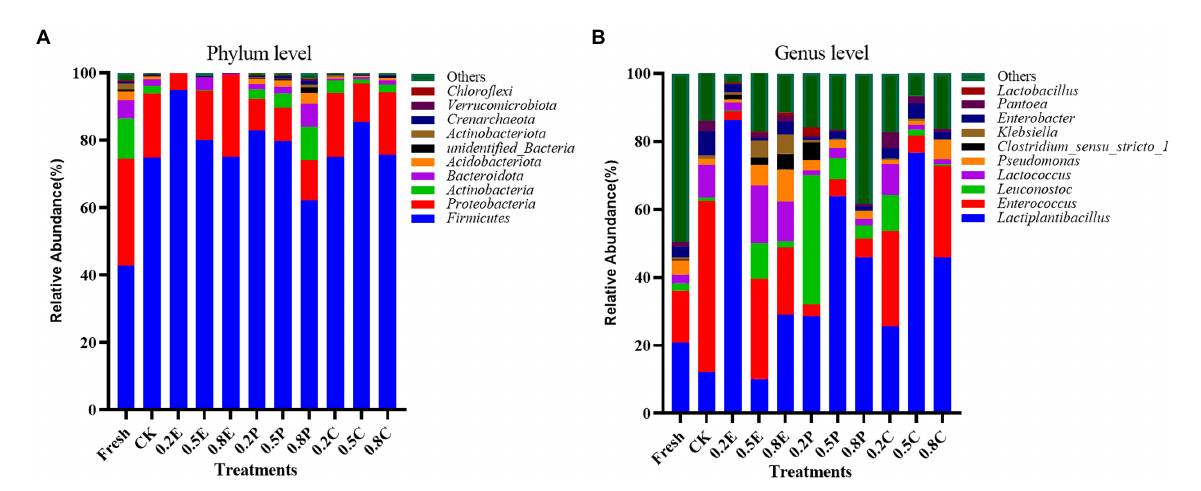
FIGURE 2 Relative abundance of bacteria at day 60 identified at (A) , the phylum level and (B) , the genus level according to the classification of the microbial community of paper mulberry silage. CK, control; E, EDTA; P, propionic acid; C, citric acid; 0.2, concentration of additive is 2 g.kg − 1 FM; 0.5, concentration of additive is 5 g.kg − 1 FM; 0.8, concentration of additive is 8 g.kg − 1